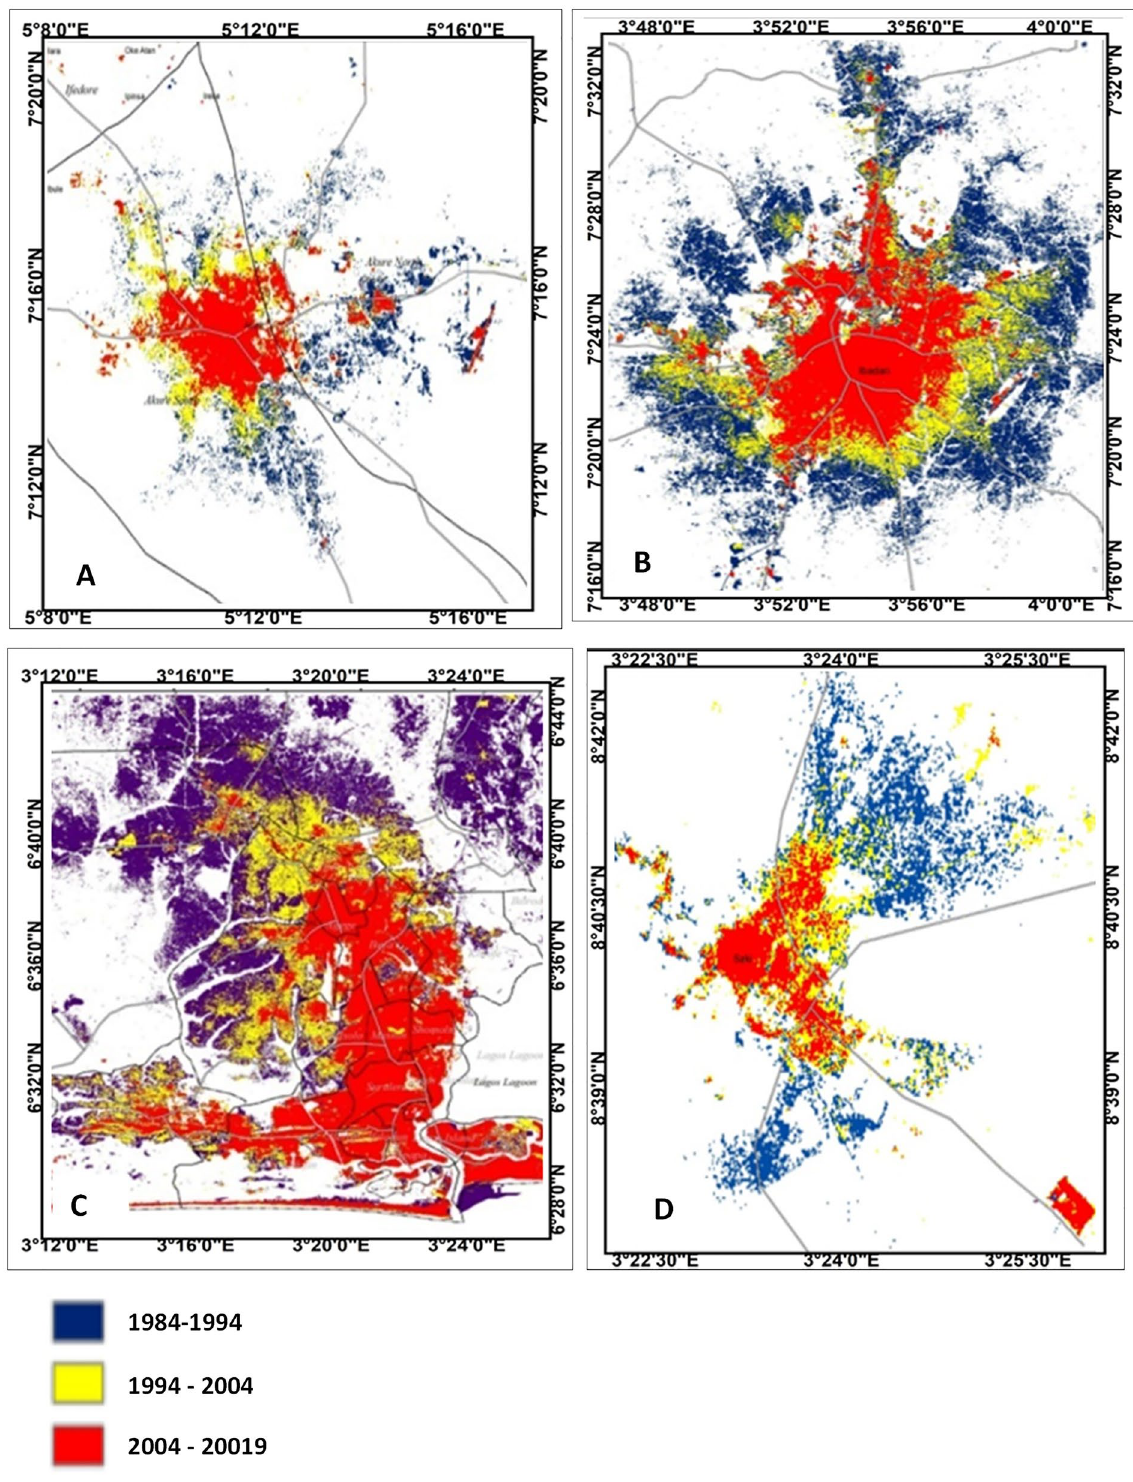
Figure 8. Changes in built-up area ( A ) Akure; ( B ) Ibadan; ( C ) Lagos; and ( D ) Saki. The Figure was generated using ArcGIS 10.5 software (http:// www. esri.